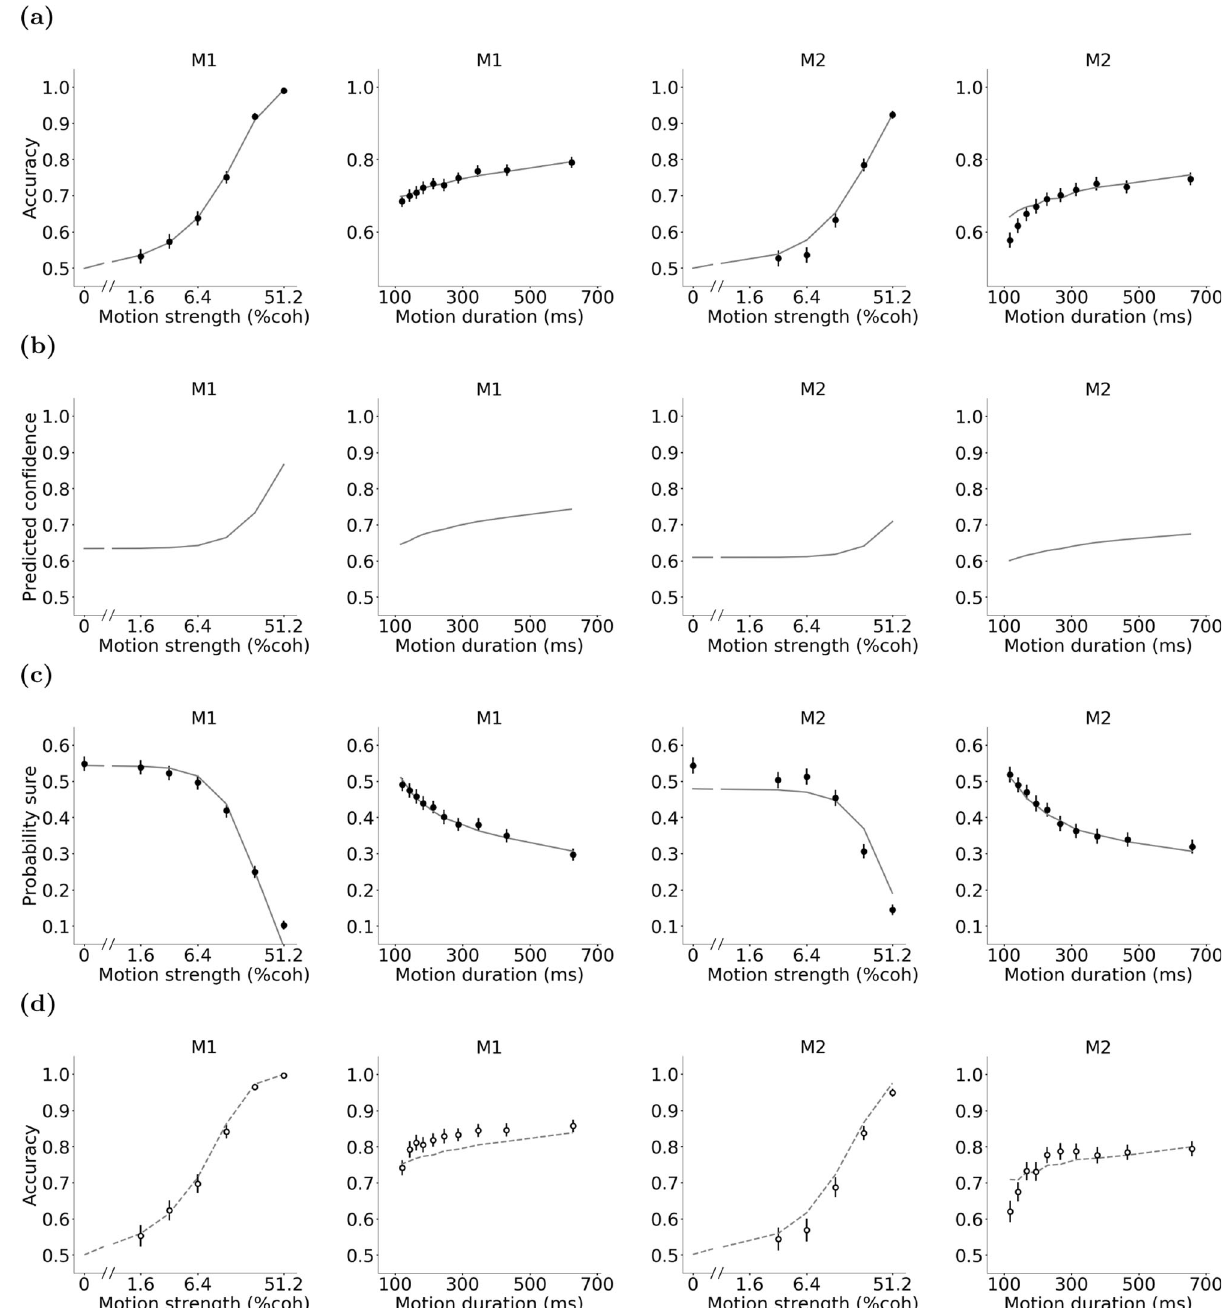
Fig. 4 The POMDP model captures the monkeys ’ behavior. a The model was fi t to each monkey ’ s accuracy on trials without the sure-bet option. Solid lines are model fi ts and data points are the measured accuracy for each motion strength and duration for monkeys M1 and M2. b The model parameters obtained from the fi ts in ( a ) were used to predict con fi dence for each motion strength and duration for each monkey. c Predictions of the POMDP model about con fi dence were thresholded to fi t the likelihood of choosing the sure-bet option (see Methods). d With the model parameters fully constrained by accuracy on trials without the sure-bet target and the likelihood of choosing the sure-bet target when it was presented to the monkey, we predicted the monkey ’ s accuracy on trials in which the sure-bet target was shown but ignored. Lines are model predictions. Data points are the same as in Fig. 1b, c. Error bars indicate